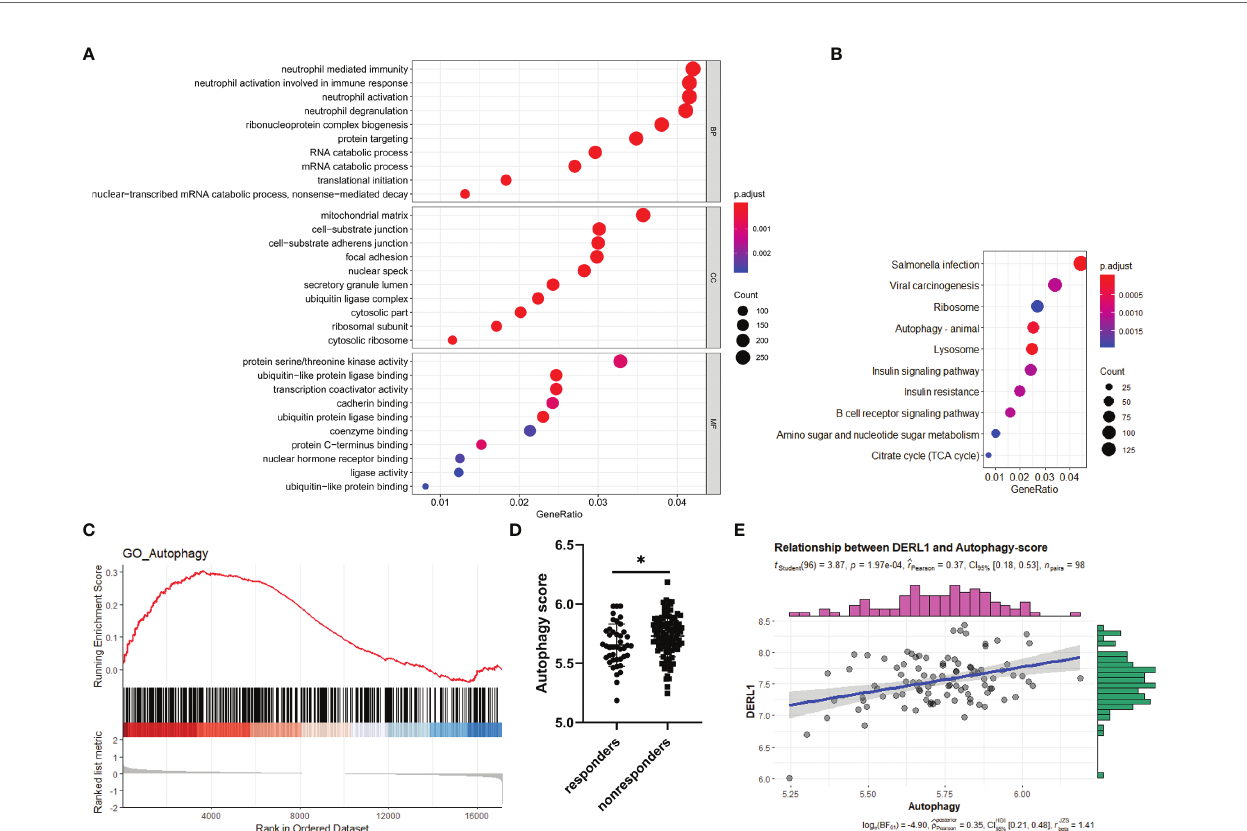
FIGURE 6 | Potential role of DERL1 in nonresponse to IFX therapy for RA. (A, B) The GO and KEGG analysis of the genes screened out through a batch correlation analysis between DERL1 and other genes in nonresponders of GSE78068 dataset. (C) Gene set enrichment analysis (GSEA) for comparing autophagy gene term between responders and nonresponders in GSE78068 dataset. (D) Differential autophagy score between responders and nonresponders in GSE78068 dataset. (E) Scatter plot of the relationship between DERL1 expression and autophagy score in nonresponders of GSE78068 dataset. Student ’ s-t test was used for the data analyses in (D) . * P <